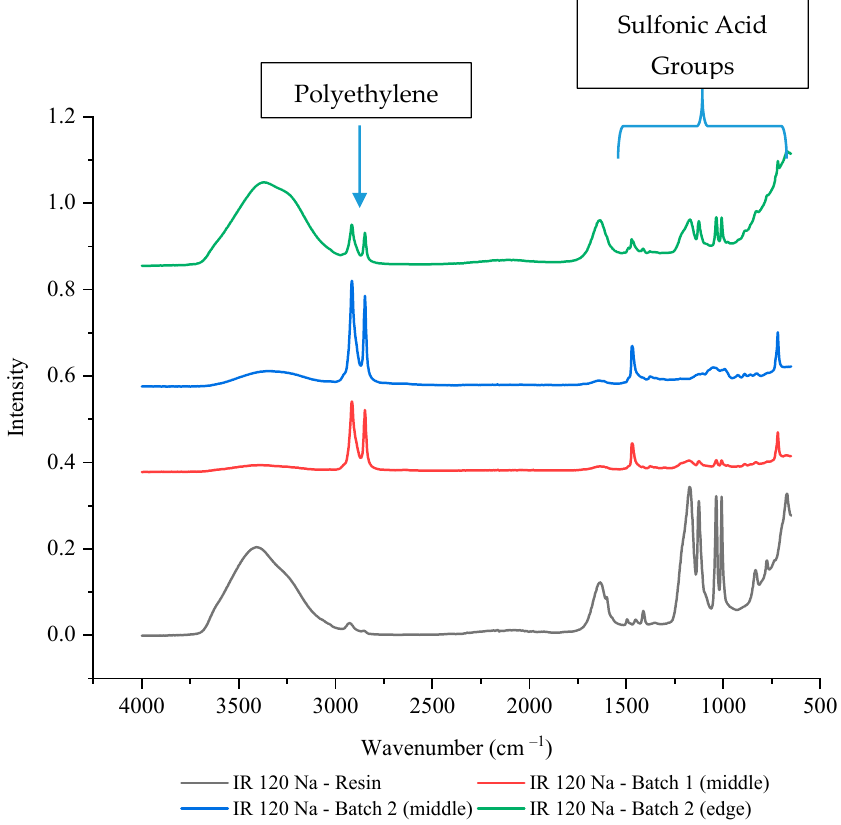
Figure 6. The FTIR-ATR spectrum of IR 120 Na + resin alone and in two different wafers. The weak cation exchange resins both have carboxylic acid functional groups which should have a peak between 1760 to 1690 cm − 1 for the C=O stretch and a peak between 1320 to 1210 cm − 1 for the C–O stretch [47]. Unlike the strong cation exchange resin wafers,